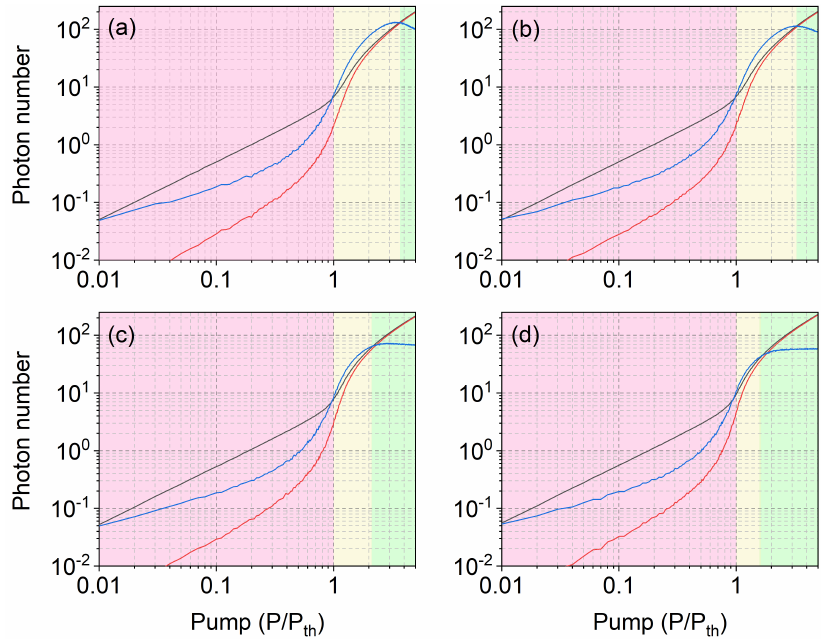
Figure 3. Average total emissions (black) and stimulated fractions (red) in a β = 0.1 nanolaser for feedback fraction: 0.5% ( a ) ; 1% ( b ); 5% ( c ); and 10% ( d ), respectively. The blue curves are the corresponding standard deviations of the stimulated